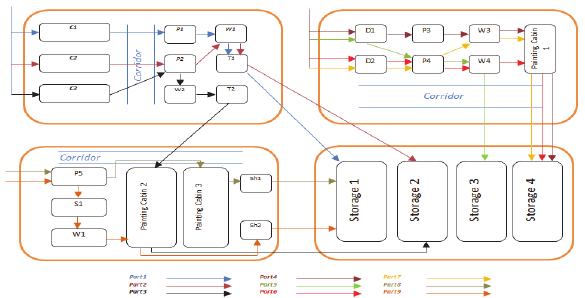
Fig. 1. A Flow Diagram of worker assignment in a Cellular Manufacturing